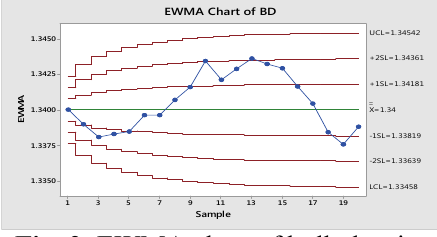
Fig. 2. EWMA chart of bulk